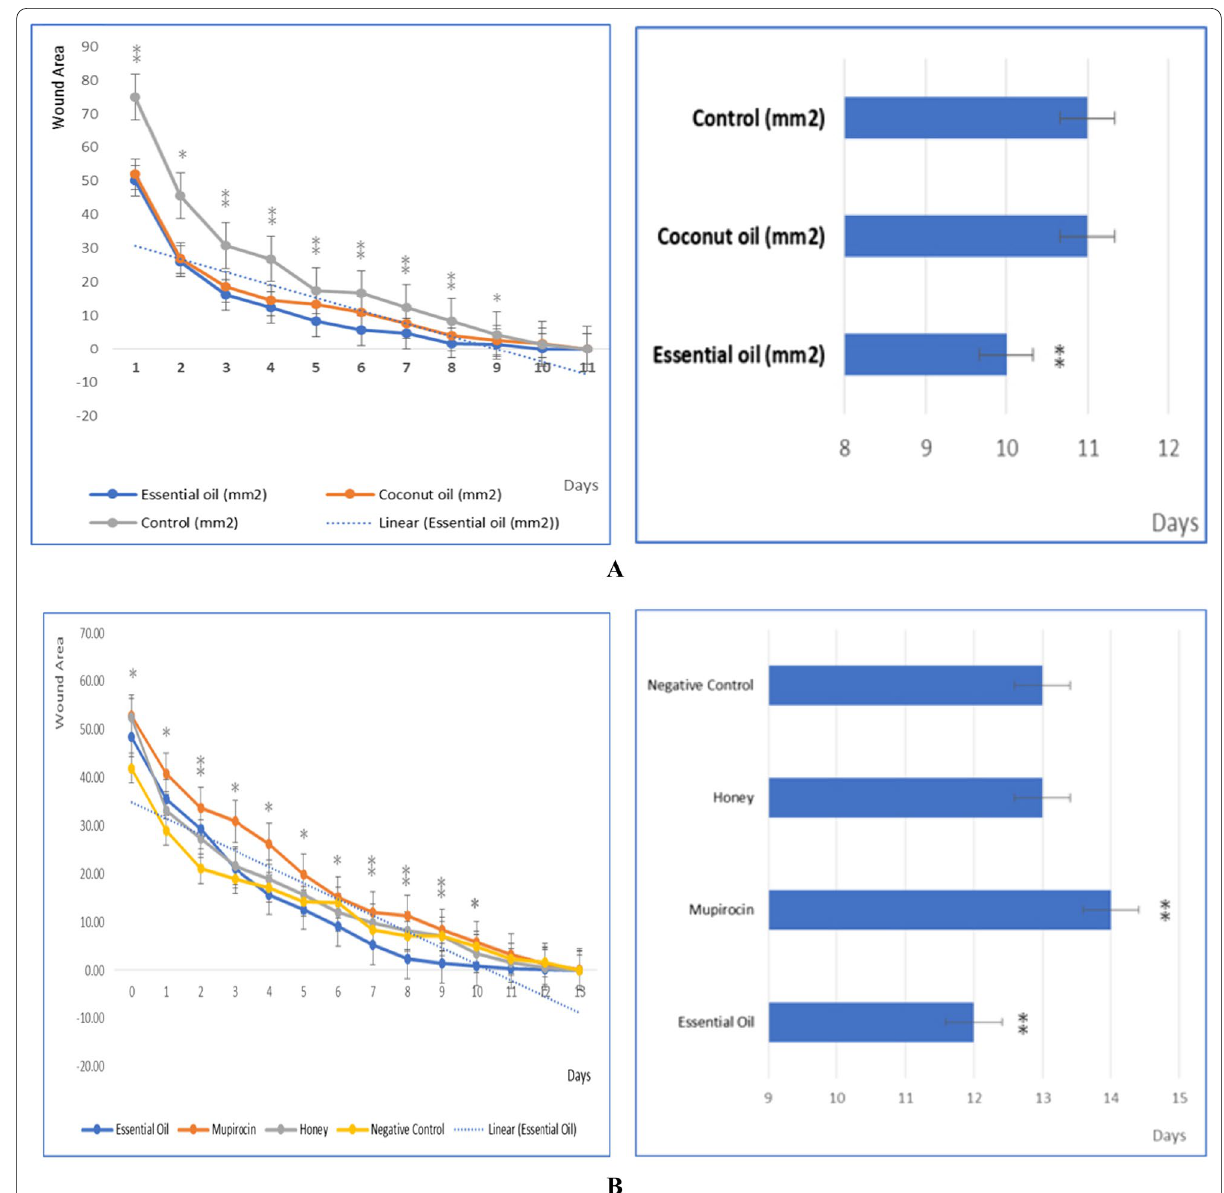
Fig. 4 Wound healing progression in the three sets of mice A 1st set of mice (n presented as mean